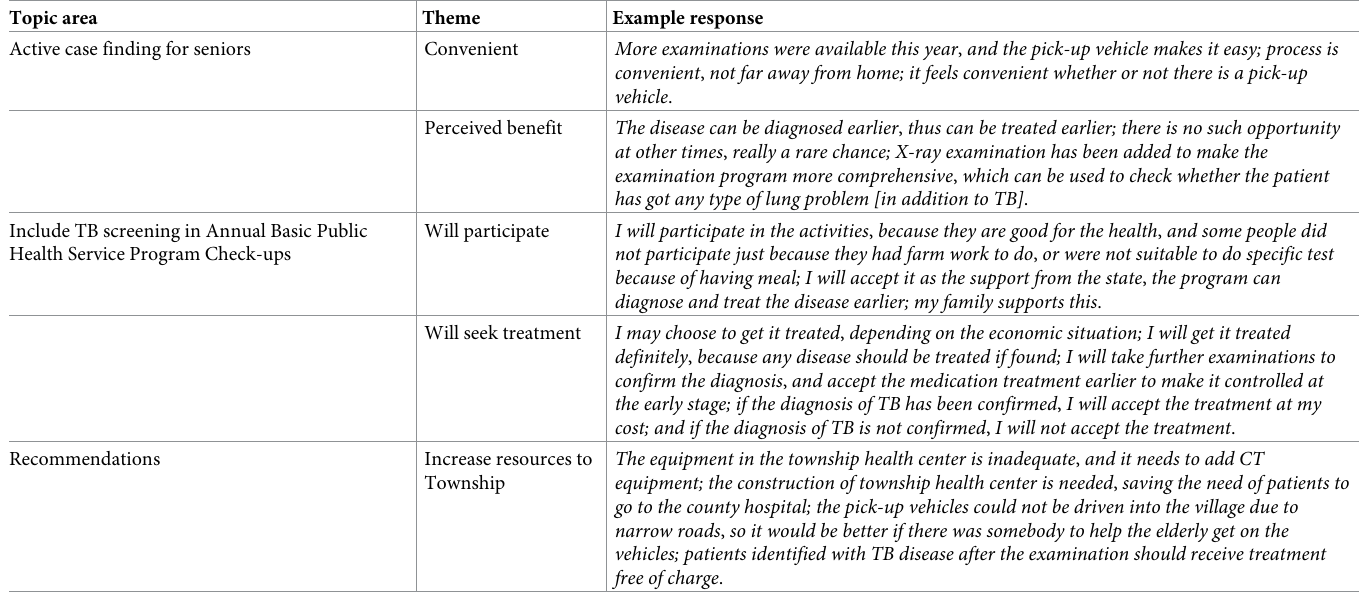
Table 5. Feedback from seniors on perceptions of active case finding project captured through in-depth interviews, Bayi township, Sichuan Province, China, March–June 2017 � . Topic